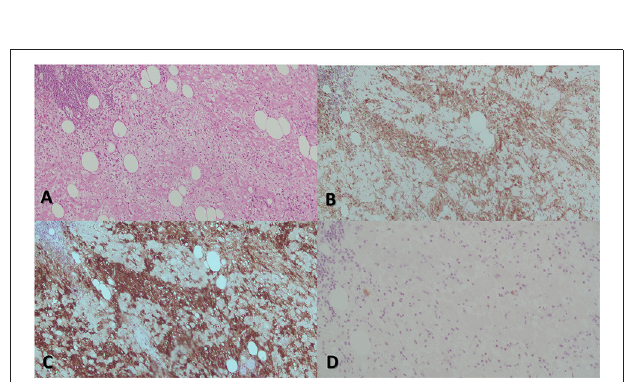
FIGURE 4 | The most prominent histological feature is expansion of the cardiac muscular cells that are filled with histiocytes (A) . These characteristically have abundant, often vacuolated cytoplasm, rounded nuclei with coarse chromatin, and a single prominent nucleolus. The atypical histiocytes express CD68 (B) . In contrast to reactive sinus histiocytes, they are S100 positive (C) but negative for CD1a (D) . All these features are consistent with RDD.